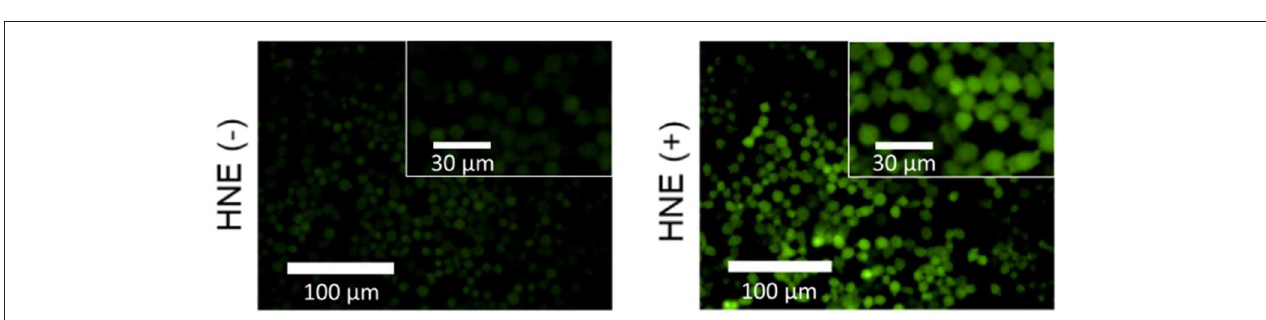
FIGURE 2 | Widefield fluorescence micrographs of RAW 264.7 cells incubated with ACS-HNE (20 µ M) before (–) or after ( + ) addition of human NE (HNE, 4 ng µ L − 1 , 100 µ L); Excitation and emission wavelengths for ACS-HNE are 460–490nm and 500–550nm, respectively. The insert shows magnified sections of the corresponding fluorescence micrograph.